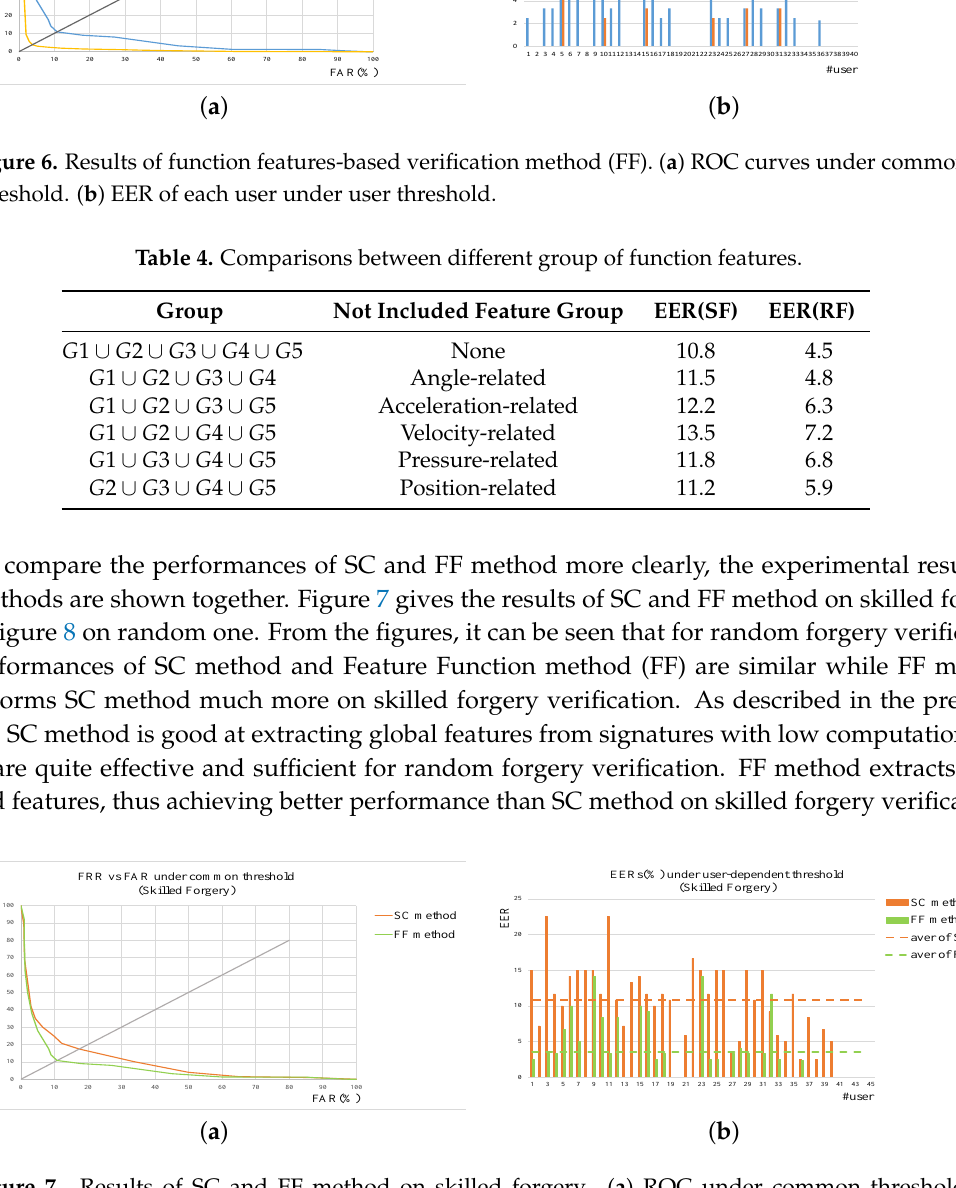
Figure 7. Results of SC and FF method on skilled forgery. ( a ) ROC under common threshold. ( b ) EER of each user under user threshold. In addition, those dotted lines are the average levels of corresponding